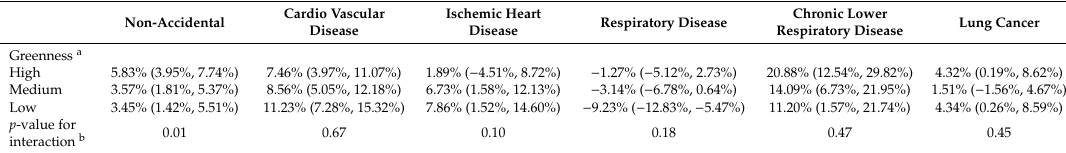
Table 3. Percent changes in cause-specific mortality per 10 µ g / m 3 increase in PM 10 by the level of